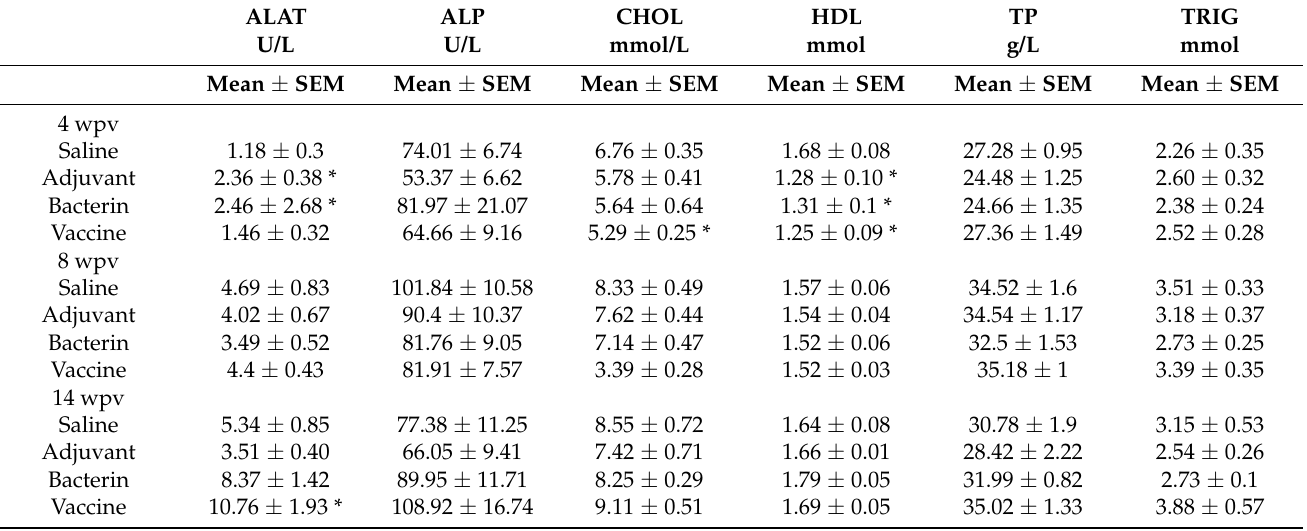
Table 1. Plasma parameters in different groups of fish. The blood parameters were analyzed in duplicate by absorption photometry using a Cobas 8000 apparatus (Roche Diagnostics, Denmark). Groups were compared to the saline control group using Student’s t -test, *: p < 0.05. A total of 10 (2 × 5) (n = 10) fish were sampled at each time point from each